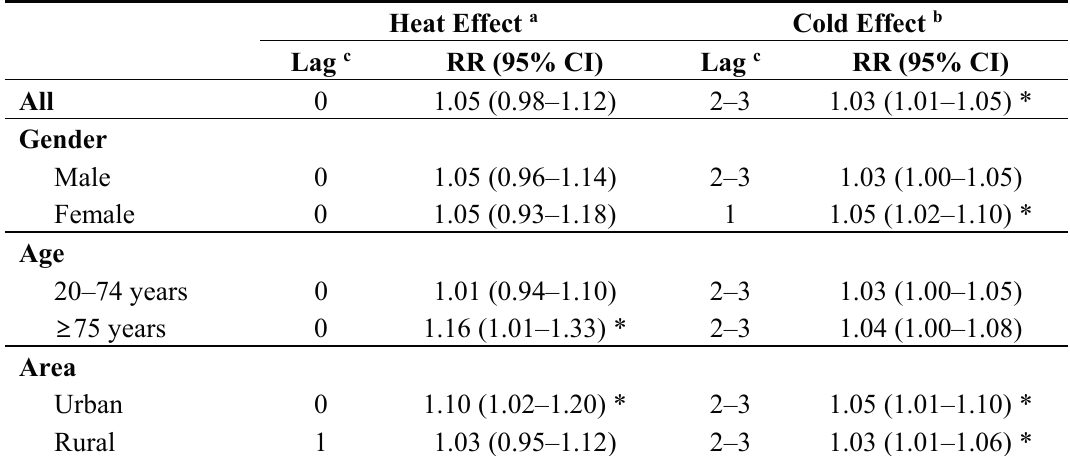
Table 3. The relative risk (RR) of heat and cold effects on AMI hospital admissions in hot and cold weather period by gender, age, and area.